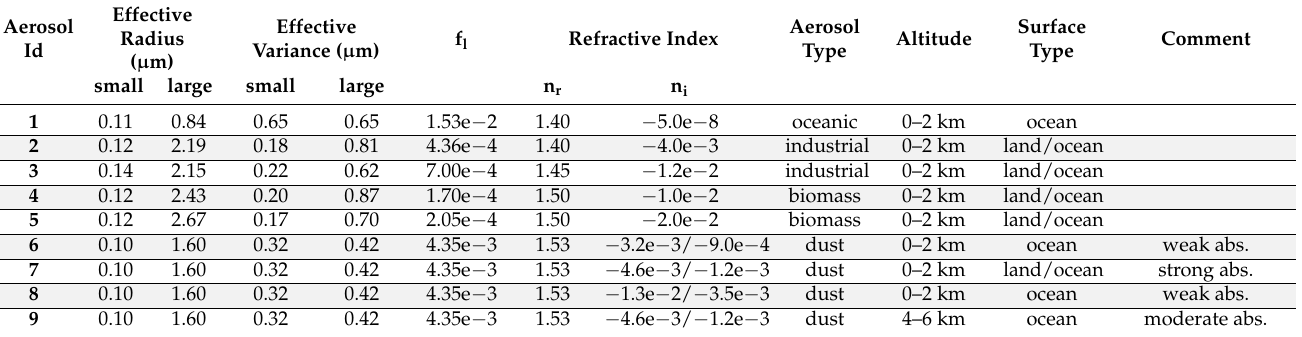
Table 3. Aerosol micro-physical properties are currently embedded in PMAp, according to Hasekamp et al. [50]. The aerosol Id from 1 to 9, the effective radius (in µ m) for the small (fine) and large (coarse) parts, the associated effective variance (in µ m), the fraction f l of large particles, the real n r and imaginary n i parts of the refractive index (values are provided at 414 nm and 640 nm when spectrally variable), the aerosol type, the altitude of the layer assumed to be homogeneous, and the surface type for which the aerosol Id is